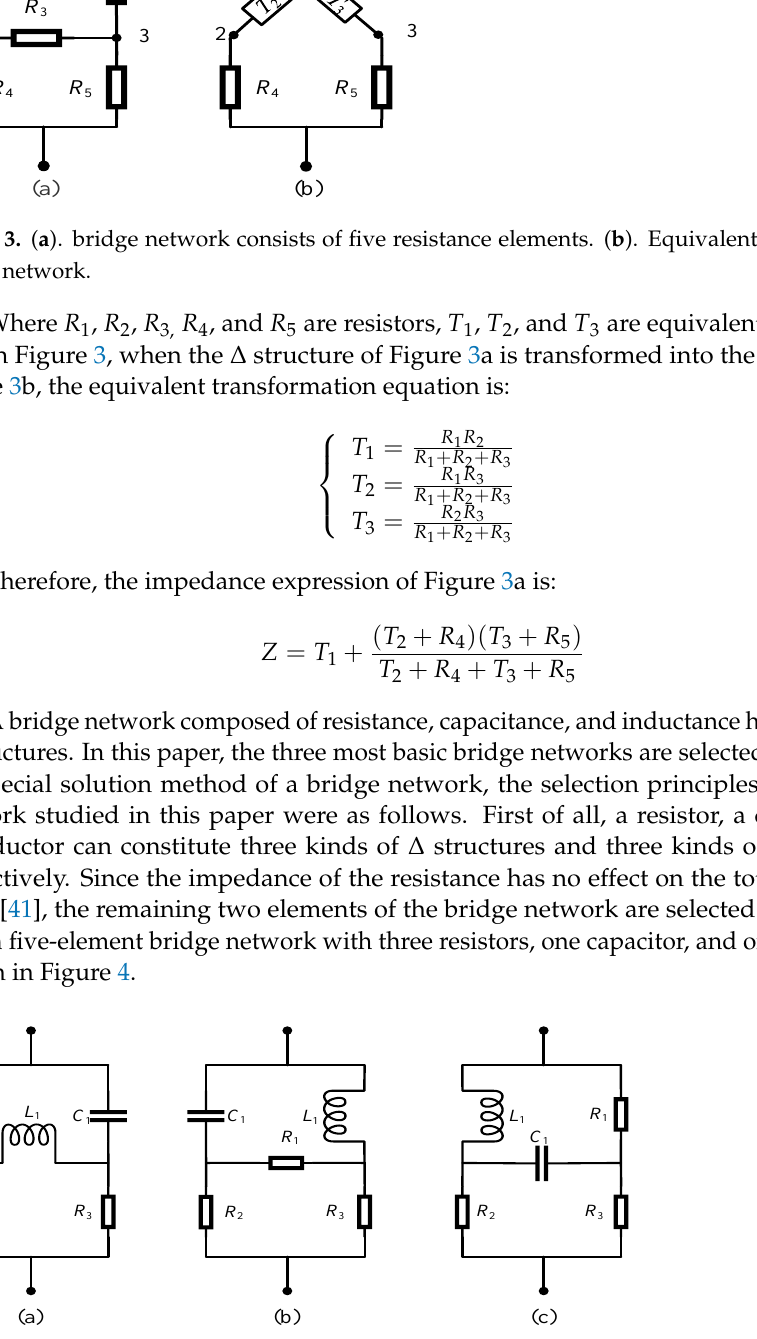
Figure 4. (a), (b), and (c) are five-element bridge networks of three different structures. Figure 4. ( a – c ) are five-element bridge networks of three different